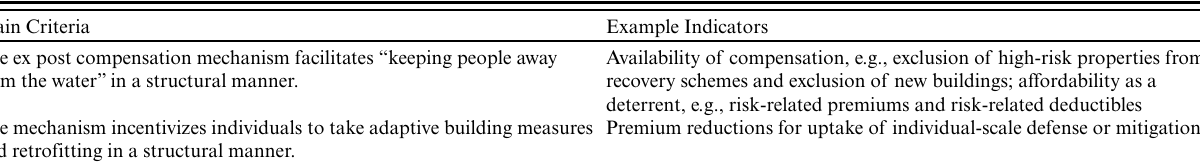
Table 1 . Main criteria for evaluating the resilience of the